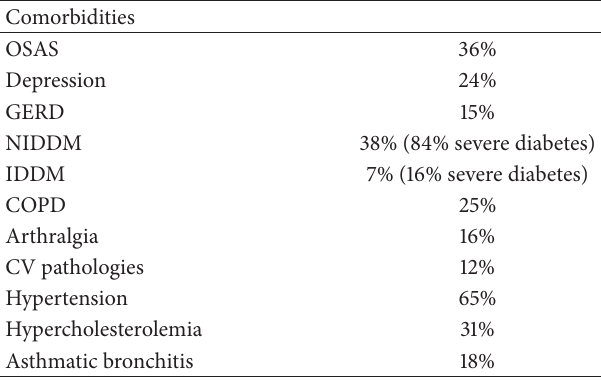
Table 3: Comorbidities of patients ( 𝑛 = 325